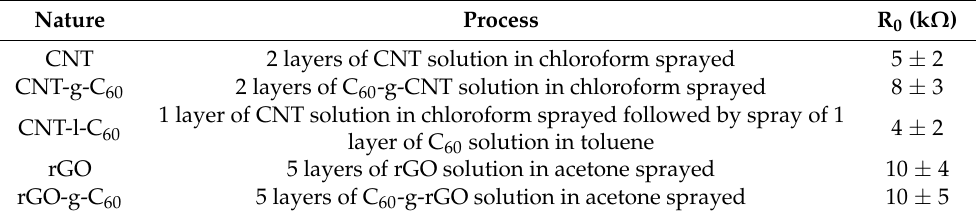
Table 1. Characteristics of hybrid sensors.